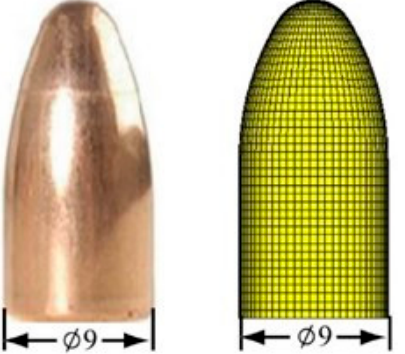
Figure 3. Size of gun bullet. (Adapted with copyright permission from Cai et al. [18]).